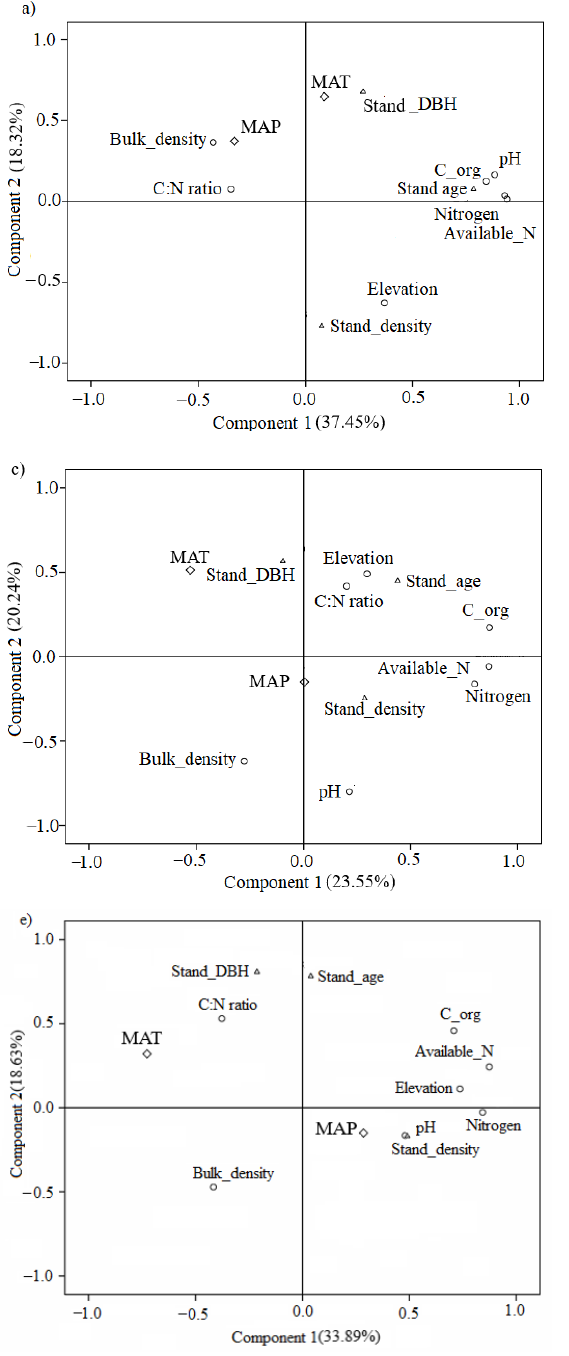
Figure 5. The principal components analysis (PCA) on the correlation matrix of soil physico-chemical characteristics, climatic conditions, and vegetation for soil microbial metabolic diversity data from five forest types in Guangxi, China, showing the dominant factors contributing to distinction between soil samples. ( a – e ) Represent evergreen broadleaf forest, deciduous broadleaf forest, mixed evergreen and deciduous broadleaf forest, bamboo forest, and warm coniferous forest, respectively. MAT, mean annual temperature; MAP, mean annual precipitation; SOC, soil organic carbon; Available_N, available nitrogen; Bulk_density, soil bulk density; Nitrogen, total nitrogen; pH, soil pH; Stand_DBH, average stand DBH; Stand_age, average stand age; Stand_density, average density of stands.